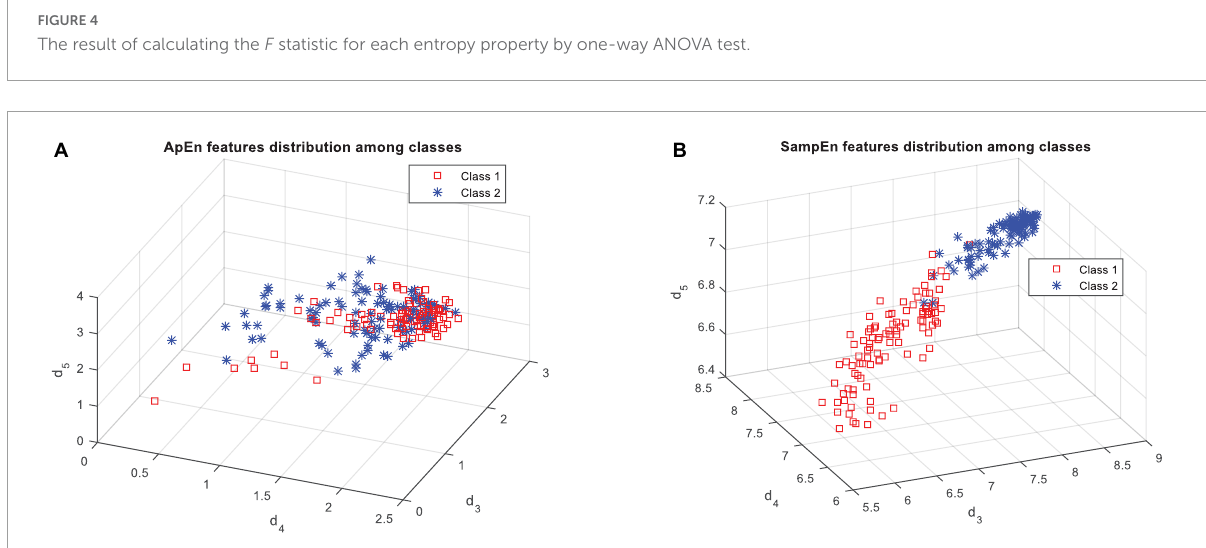
FIGURE5 Distribution of samples on target classes based on the features obtained from panel (A) approximate entropy (ApEn), and (B) sample entropy